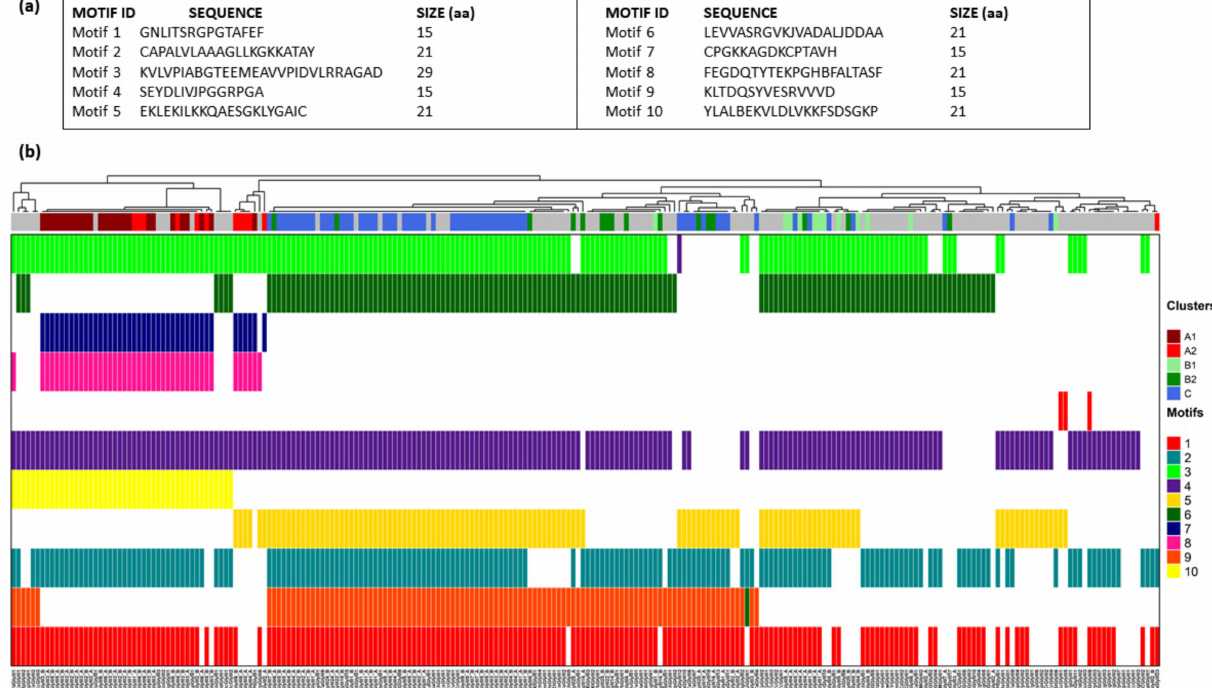
Figure 6. Motif organization pattern of domain sequences of GLYIII proteins from different organisms reveal distinct evolutionary trajectory of plant GLYIII clusters. ( a ) List of conserved motifs predicted in the domain sequences of GLYIII proteins from 69 species. ( b ) Heatmap showing distribution of motifs in domain sequences of all organisms under study. A total of ten motifs were identified in different combinations as depicted by different colors. Color strip on the top indicates clusters to which respective proteins belong. Gray indicates proteins not being clustered into either of the three Clusters- A (A1 and A2), B (B1 and B2), or C. MEME suite was used for prediction of